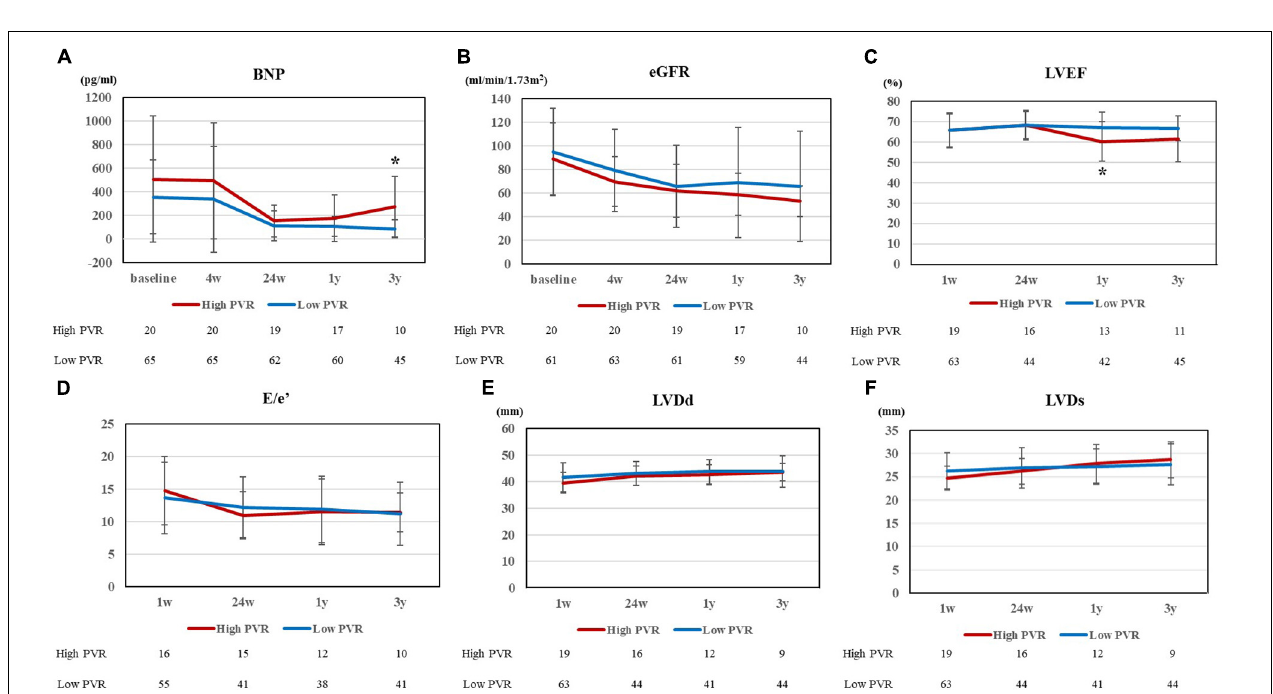
FIGURE 3 | (A) BNP and (B) eGFR at 5 points (baseline, 4 weeks, 24 weeks, 1 year, and 3 years after HTx), (C) LVEF, (D) E/e’, (E) LVDd, and (F) LVDs at 4 points (1 week, 24 weeks, 1 year, and 3 years after HTx) for high and low PVR group. BNP, brain natriuretic peptide; eGFR, estimated glomerular filtration ratio; HTx, heart transplantation; LVEF, left ventricular ejection fraction; LVDd, left ventricular end diastolic dimension; LVDs, left ventricular end systolic dimension; and PVR, pulmonary vascular resistance. * p < 0.01.